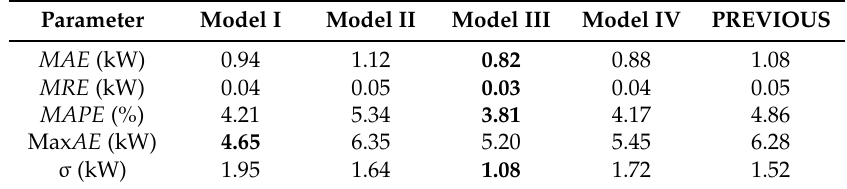
Table 15. Results obtained by MOGA and PREVIOUS models over Test D, for a PH of 1 h.